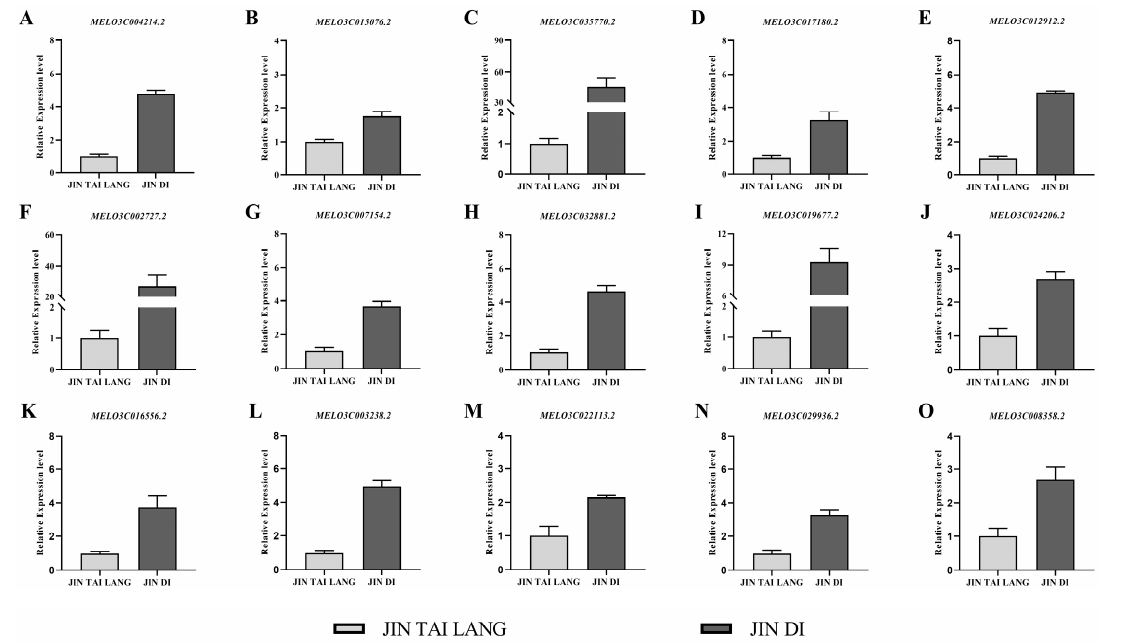
Figure 8. The quantitative real-time PCR (qRT-PCR) was used to analyze 15 DEGs in the most significant KEGG enrichment pathway in the ‘JIN TAI LANG’ and ‘JIN DI’ varieties. The corresponding gene expression levels of photosynthetic antenna protein are as follows: Lhca1 protein ( A ); Lhca3 protein ( B ); Lhca4 protein ( C , D ); Lhcb1 protein ( E – I ); Lhcb2 protein ( J ); Lhcb3 protein ( K ); Lhcb4 protein ( L ); Lhcb5 protein ( M ); Lhcb6 protein ( N – O ).Values are represented as the means ± SD ( n = 9).